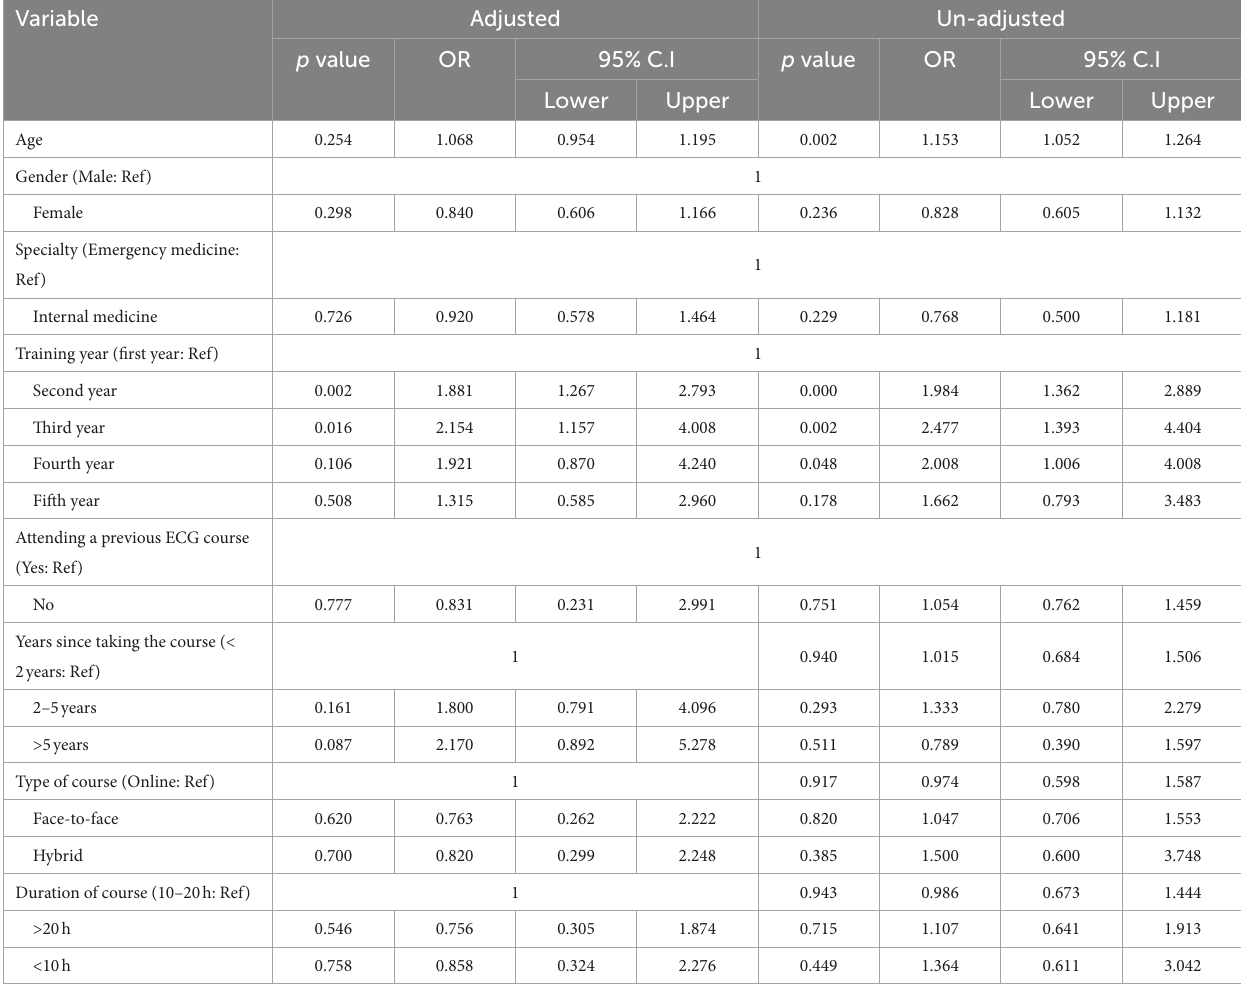
TABLE 4 Binary logistic regression to determine the appropriate level of knowledge regarding ECG